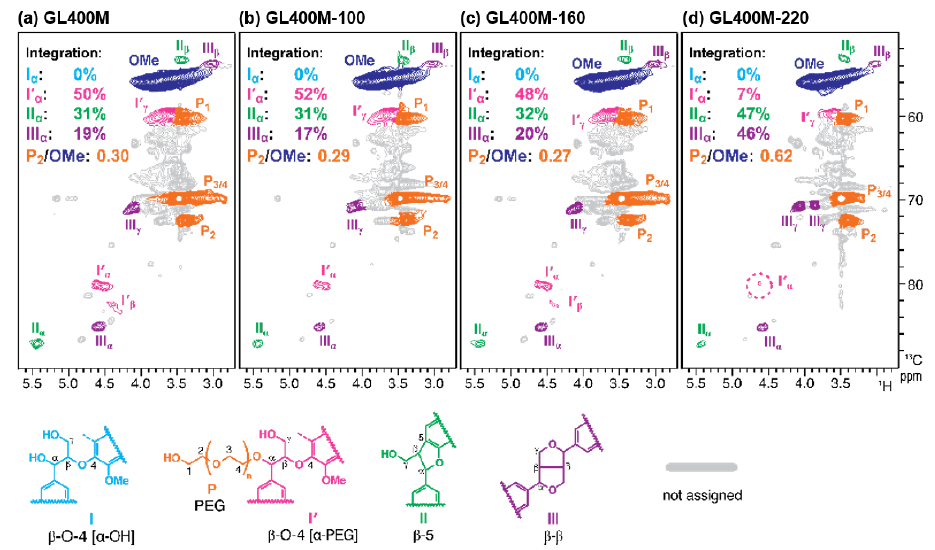
Figure 3. Two-dimensional (2D) HSQC NMR spectra of GL400M before heat treatment ( a ) and after heat treatment at 100 °C ( b ), 160 °C ( c ), and 220 °C ( d ) for 1 h. GL400M was obtained via acid-catalyzed PEG400 solvolysis of JC wood meal (JC-M).